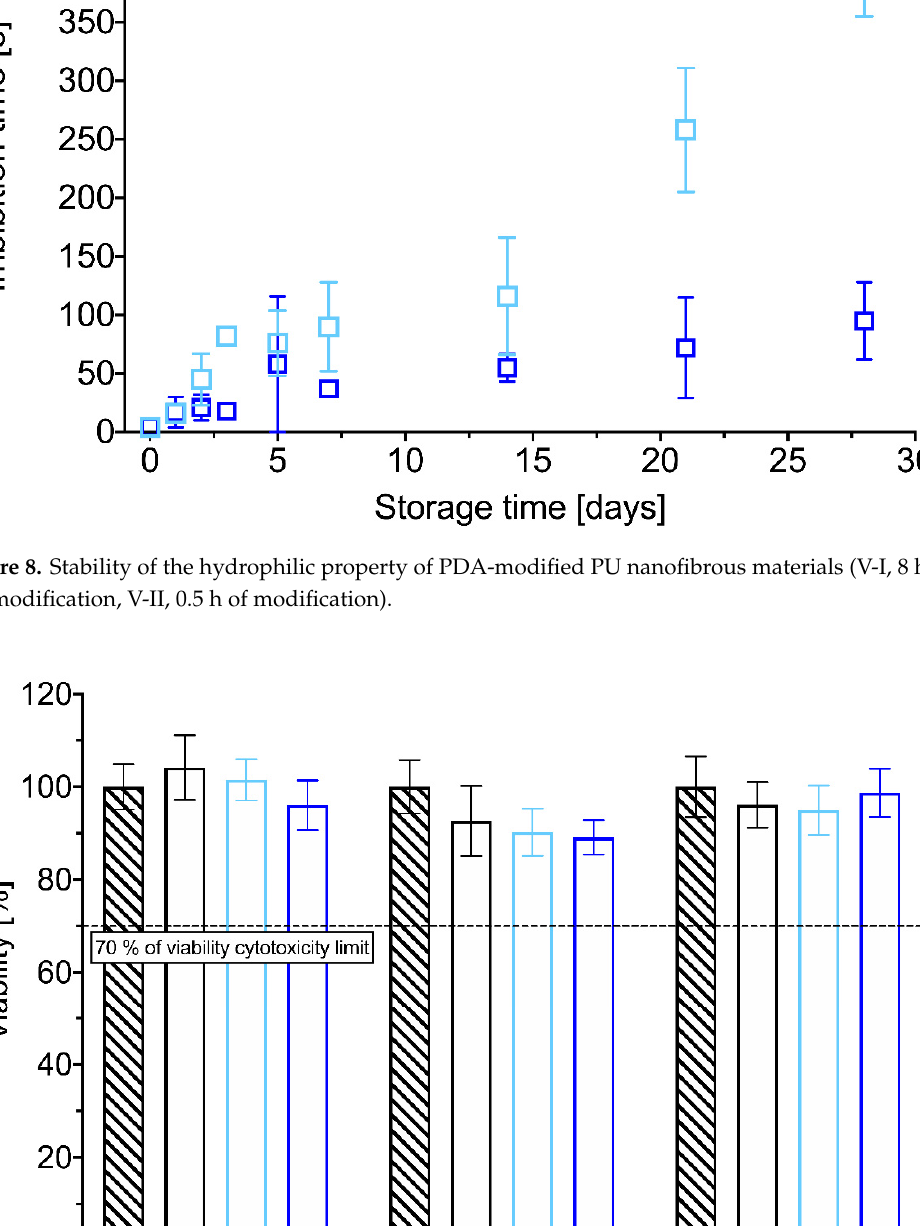
Figure 9. XTT cytotoxicity evaluation of extracts from unmodified PU and PDA-modified (VI—8 h